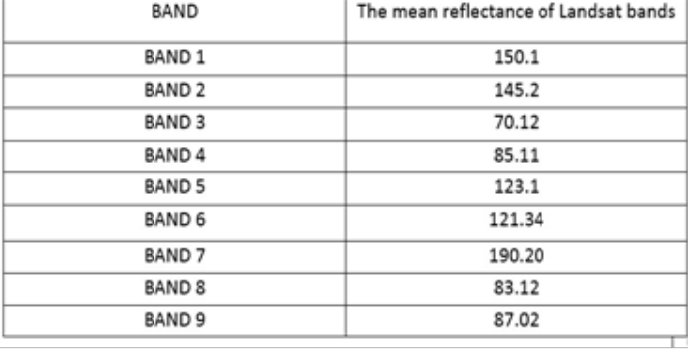
Table 1- The mean reflectance of Landsat